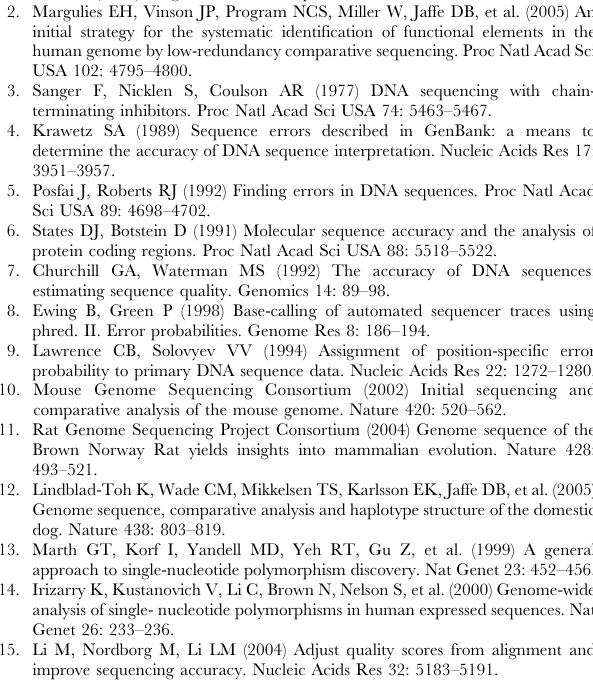
Figure S6 Performance of base masking algorithms which use linear-regression framework, for four spe- cies. The dark black lines show the baseline results using only quality scores. In red are the results where regression is performed on the quality scores and a phylogenetic odds ratio comparing a model with error to a model without error. In purple, blue, and green, respectively, are results which use both quality score and GC percentage in a 10 bp window, the minimum quality score in a 10 bp window, and the mean quality score in a 10 bp window. The only factor which seems to have a positive effect on the prediction is the phylogenetic odds ratio.